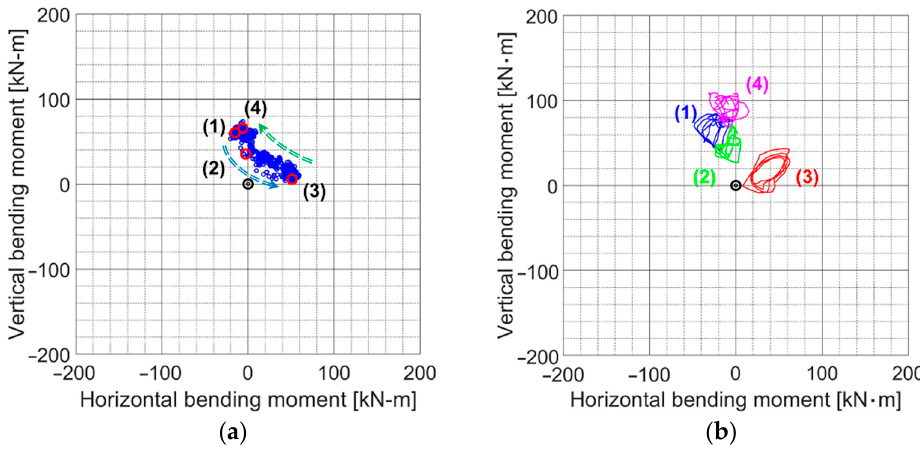
Figure 11. Trajectory plot of bending moment during rapid port turn. ( a ) Nominal bending moment;